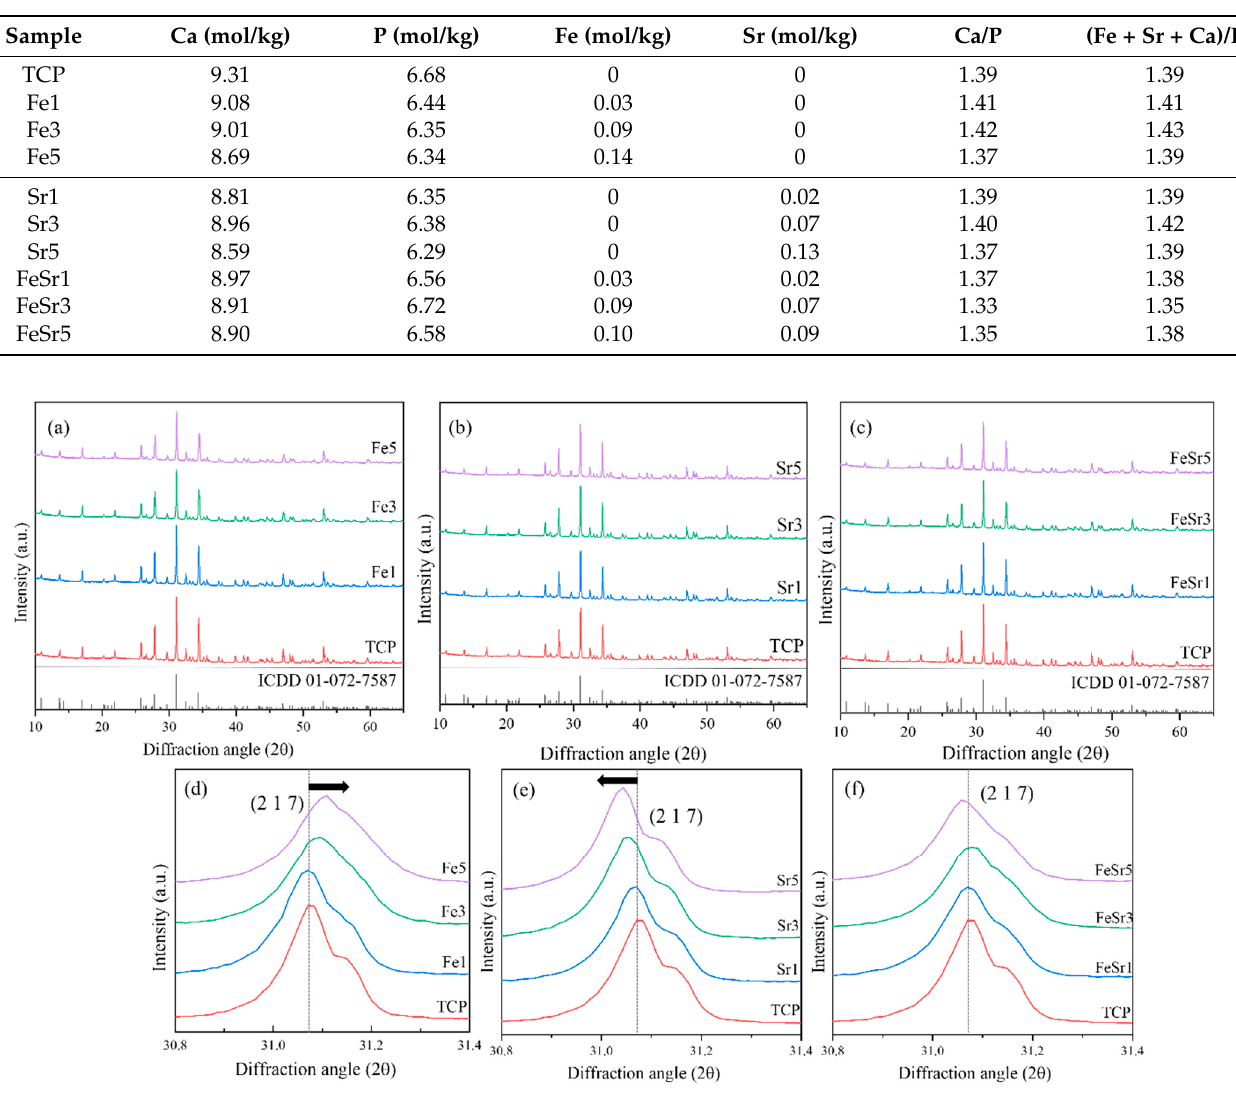
Figure 1. XRD patterns of various β -TCP powders with: ( a – c ) 2 θ : 10–65, ( d – f ) 2 θ : 30.8–31.4.